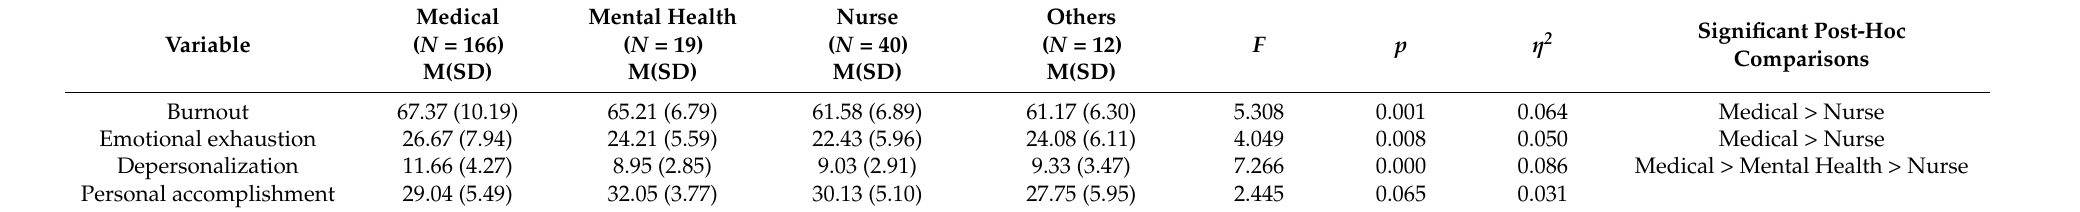
Table 3. Group differences in burnout and its subscales and residency’s